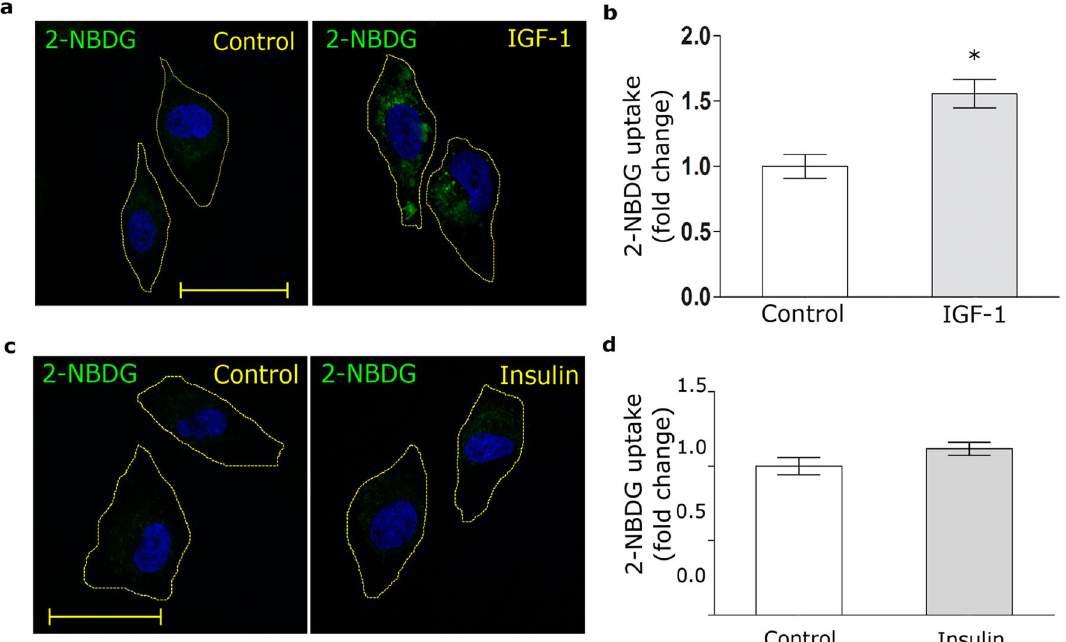
Figure 3. IGF-1 promotes glucose uptake. ( a , c ) Confocal microscopy in MIO-M1 cells treated with IGF-1 10 nM ( a ) or Insulin 10 nM ( c ) together with 2-NBDG 80 µM (green) for 30 min. Dotted line represents the cell shape. Images are representative of 20 cells per condition (n = 20). Scale bar = 15 μM. ( b , d ) Graph represents mean ± SEM of the fluorescence intensity of 2-NBDG per cell area expressed as fold change. * p < 0.05 versus non-stimulated control (white